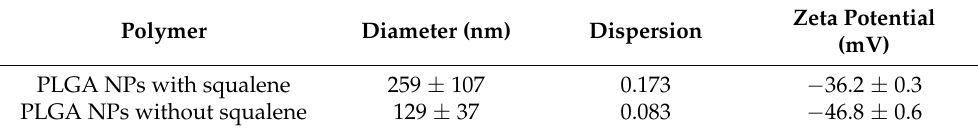
Table 2. Physicochemical characterization of PLGA nanoparticles.